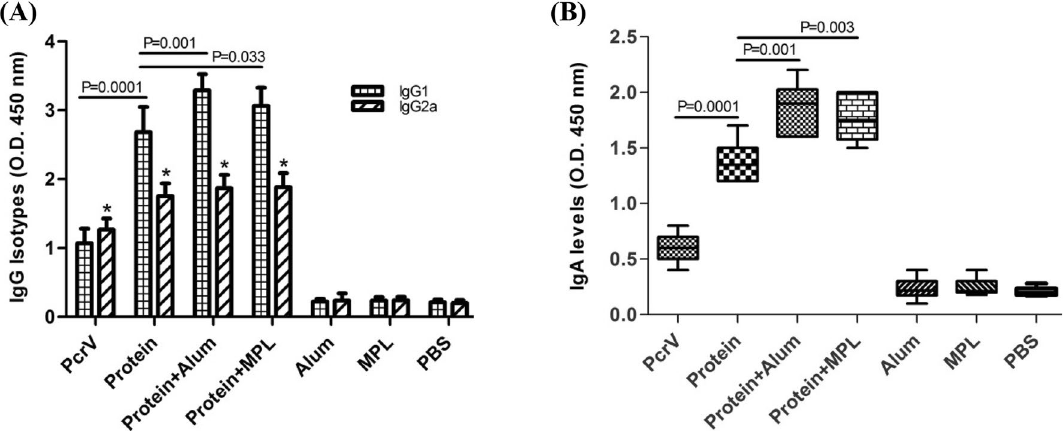
Figure 2. Analysis of isotypes antibodies responses in serum. The levels of IgG1 and IgG2a isotypes, as well as IgA responses were detected after the last immunization. ( A ) IgG1 and IgG2a, and ( B ) IgA responses. The significant levels between different groups are presented with P value. In addition, asterisks show the statstical difference in IgG2a level between the vaccinated groups with the control groups (p < 0.05). The experiments were repeated three times. The results are mean ± S.D. from 10 mice per groups at dilution 1:800.